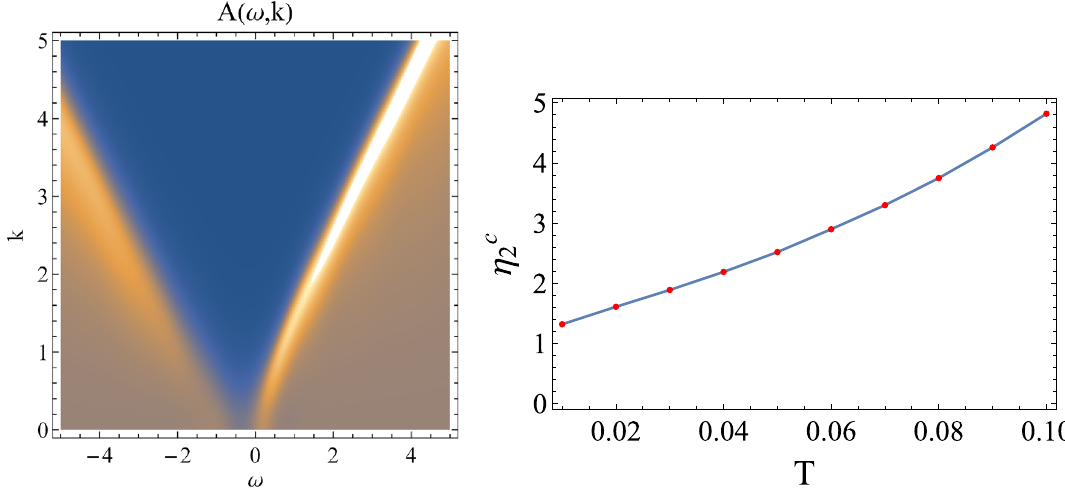
Fig. 7 Left plot: the density plot of spectral function A (ω, k ) for α = 5 and η 2 = 4 at T = 0 . 22. Right plot: the relation between T and η c fixed α =